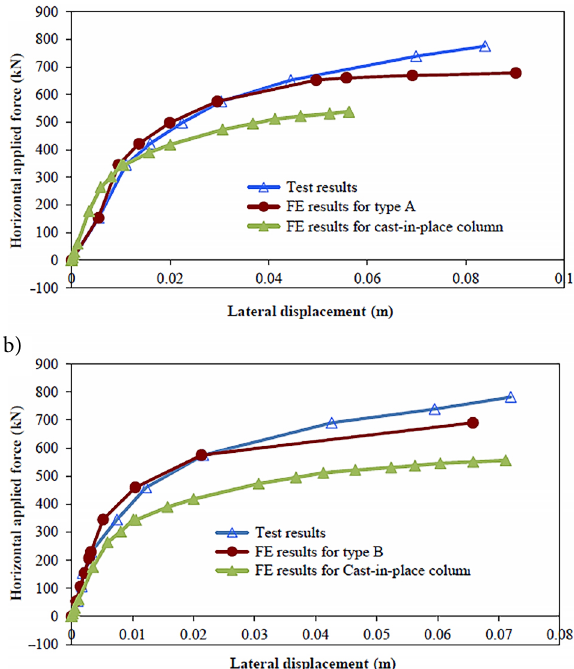
Figure 11. Lateral displacement versus horizontal applied force: